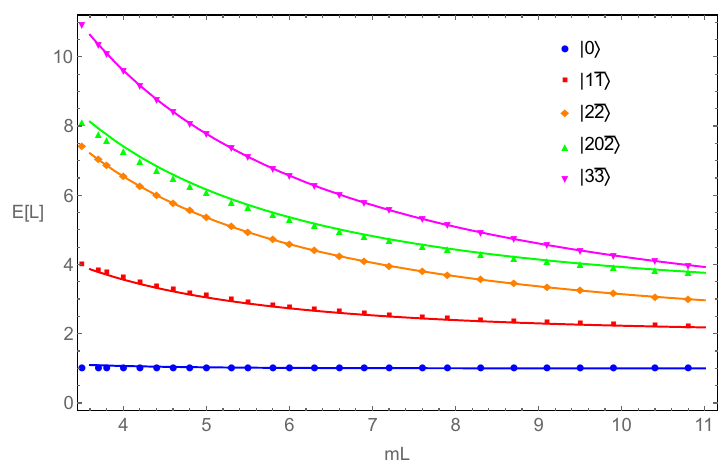
Figure 9 . Low lying (cid:12)nite size energy spectrum of the scaling Lee-Yang model obtained from TCSA with the ground state energy density subtracted. Continuous lines are the results of the Bethe-Yang equations with the various quantization numbers, while discrete data originates from